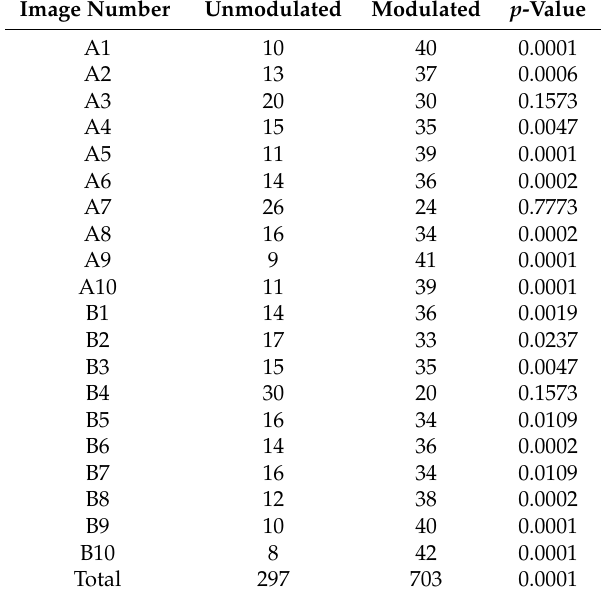
Table 2. Comparing the Liu JND model and its saliency modulated JND model based on the number of votes collected from 24 subjects. The first 10 images are from Group A, and the others are from Group